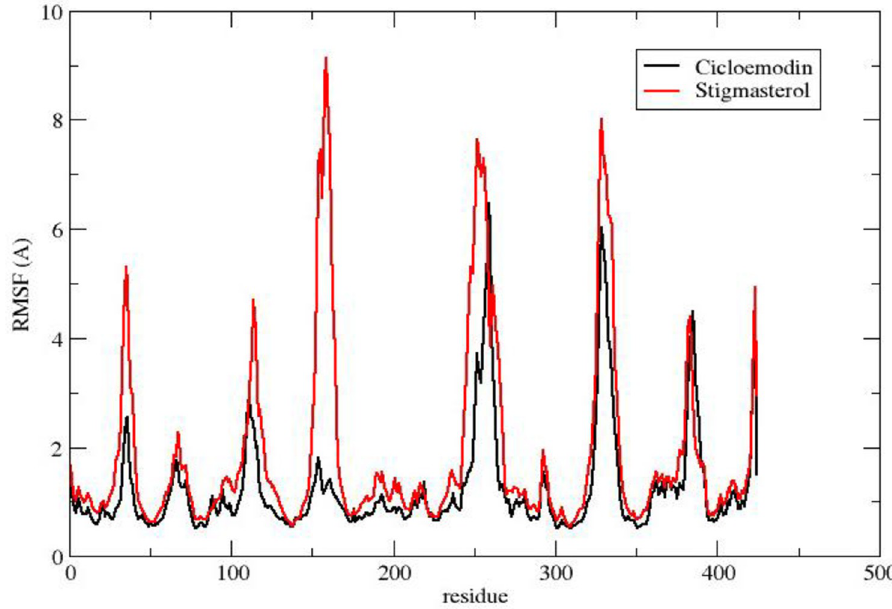
Fig 4. RMSF of active phytoconstituents in complexation with